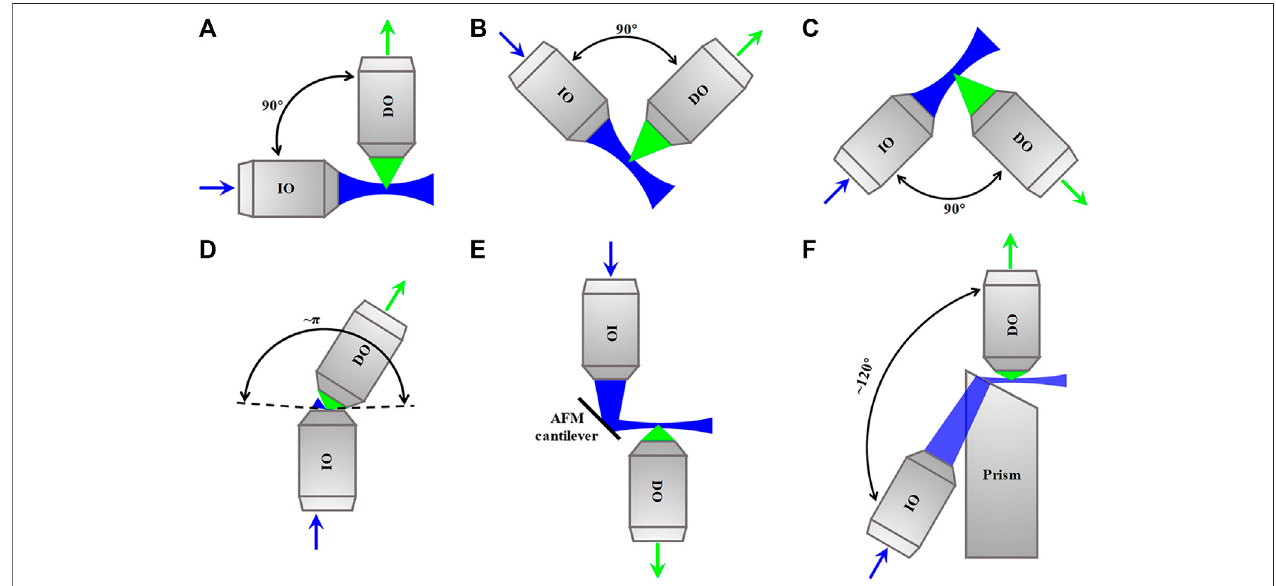
FIGURE 10 | Schematics of dual-lens LSFM methods. (A) – (C) Dual-lens LSFM methods with two orthogonal objective lenses. (D) – (F) Dual-lens LSFM methods with two non-orthogonal objective lenses. Blue and green arrows indicate the directions of the excitation beam and fl uorescence. IO, illumination objective lens; DO, detection objective lens; AFM, atomic force